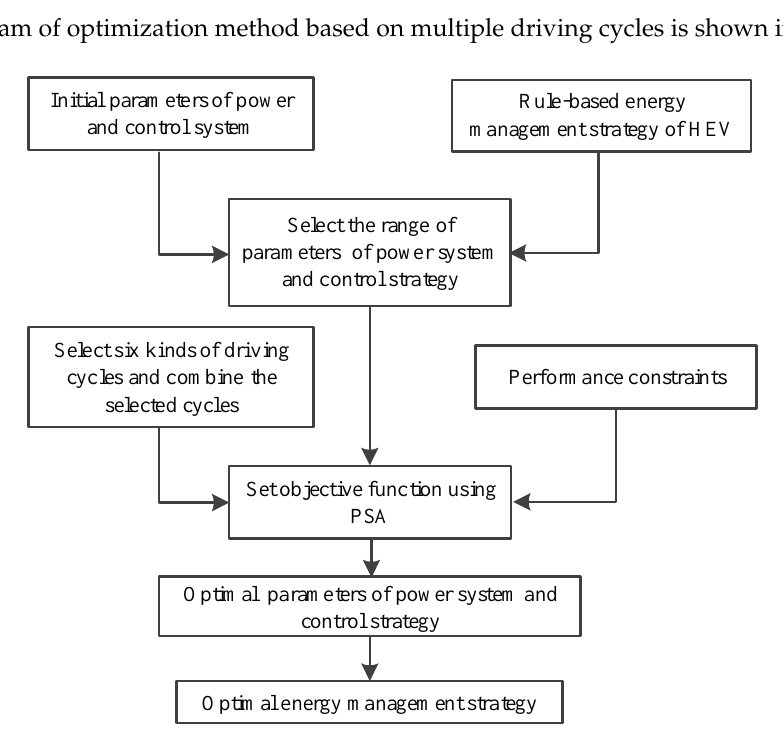
Table 5. Power source parameters of the HEV.